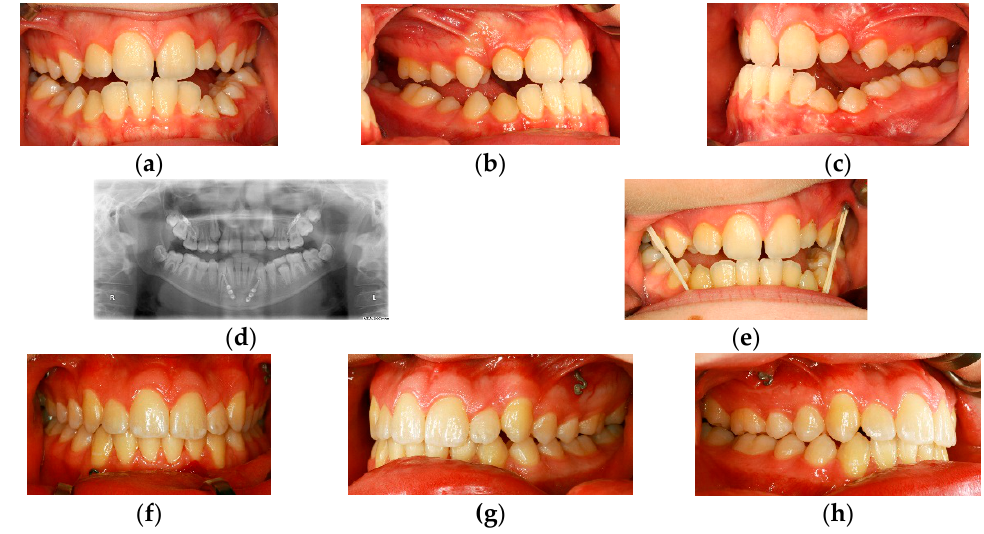
Figure 3. ( a – c ) Clinical situation in an eleven ‐ year old boy demonstrating a class III malocclusion during late mixed dentition; ( d , e ) Radiologic ( d ) and clinical situation after insertion of skeletal anchorage devices according to H. de Clerck; class III elastics are inserted in order to support maxillary growth ( e ); ( f – h ) Clinical situation after “four years of class III elastics” demonstrating correct occlusal relations.